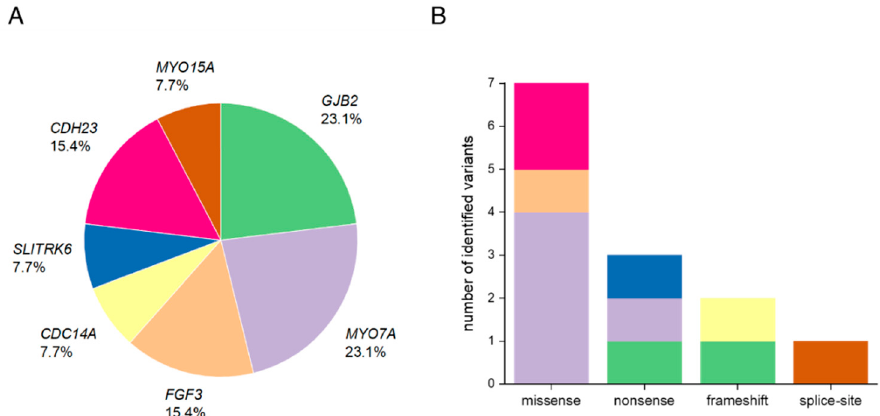
Figure 3. Overview of the affected genes and the distribution of different variant types in Pakistani families with HL. ( A ) Overall percentage of each affected gene in 13 Pakistani families. ( B ) Number of identified variants by type (missense, nonsense, frameshift, splice-site). The color code refers to the genes that are marked in ( A ).